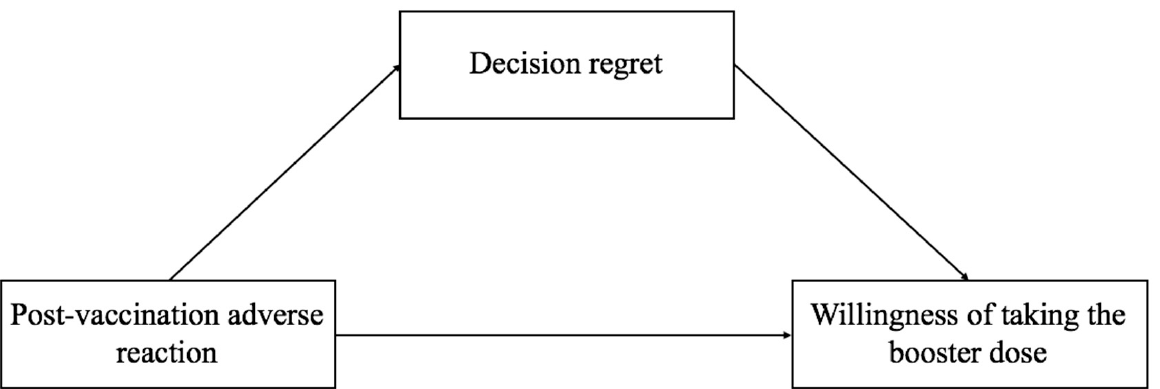
Figure 1. The directed acyclic graph describes the relation among post-vaccination adverse reactions, decision regret, and willingness of taking the booster dose of COVID-19 vaccine.